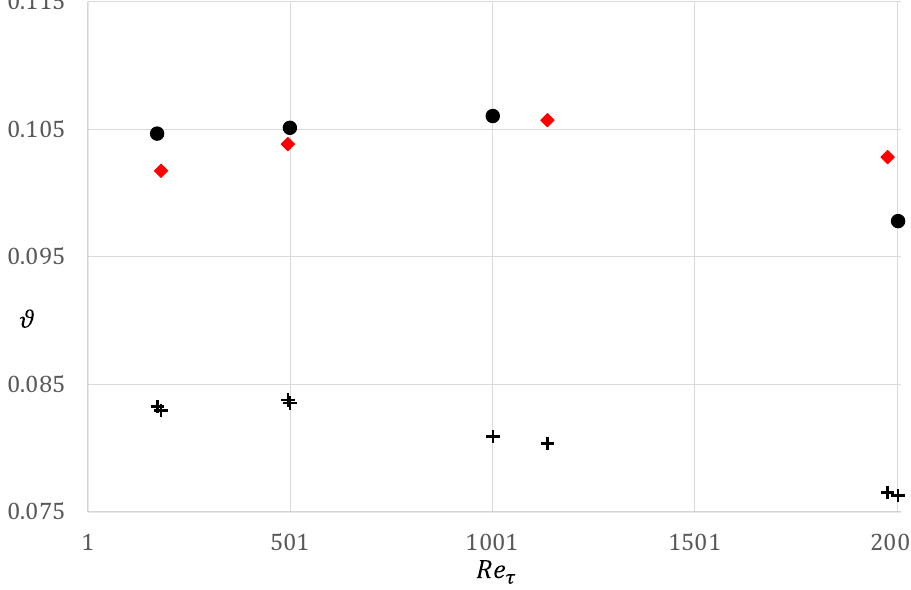
Figure 15. Trend of the momentum thickness ϑ ; • pipe DNS data [26]; (cid:7) pipe DNS data [31,32]; and + channel ITM.